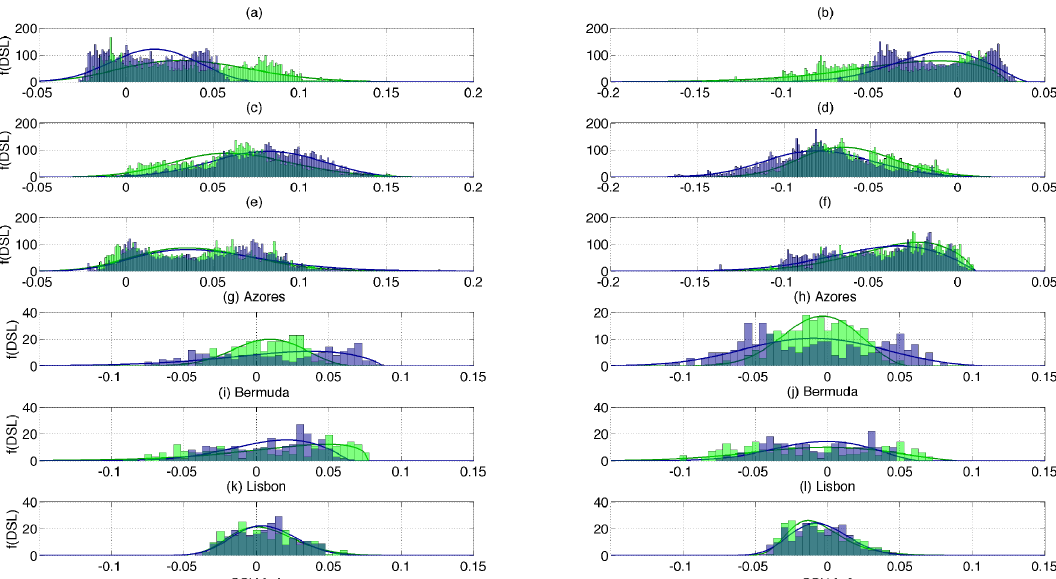
Figure 9. (a, c, e) Estimated probability density function (PDF) of daily regional maximum DSL of simulation R low regional minimum DSL in the three different regions in the North Atlantic shown in Fig. 7 ( a region of the subpolar gyre, b near the US east coast, and c near the European coast). In each plot, a maximum daily value over the region is identified after all variability with frequencies lower than 550 days has been filtered out. (g–l) Same but for the locations indicated in Fig. 7 and using (g, i, k) monthly maximum local DSL values and (h, j, l) monthly minimum local DSL values derived from daily mean time series. The green histogram is the PDF for the first 20 years (2001–2020) and the blue histogram that for the last 20 years (2081–2100). The green and blue lines are the GEV distribution function fitted to the corresponding green and blue histogram,